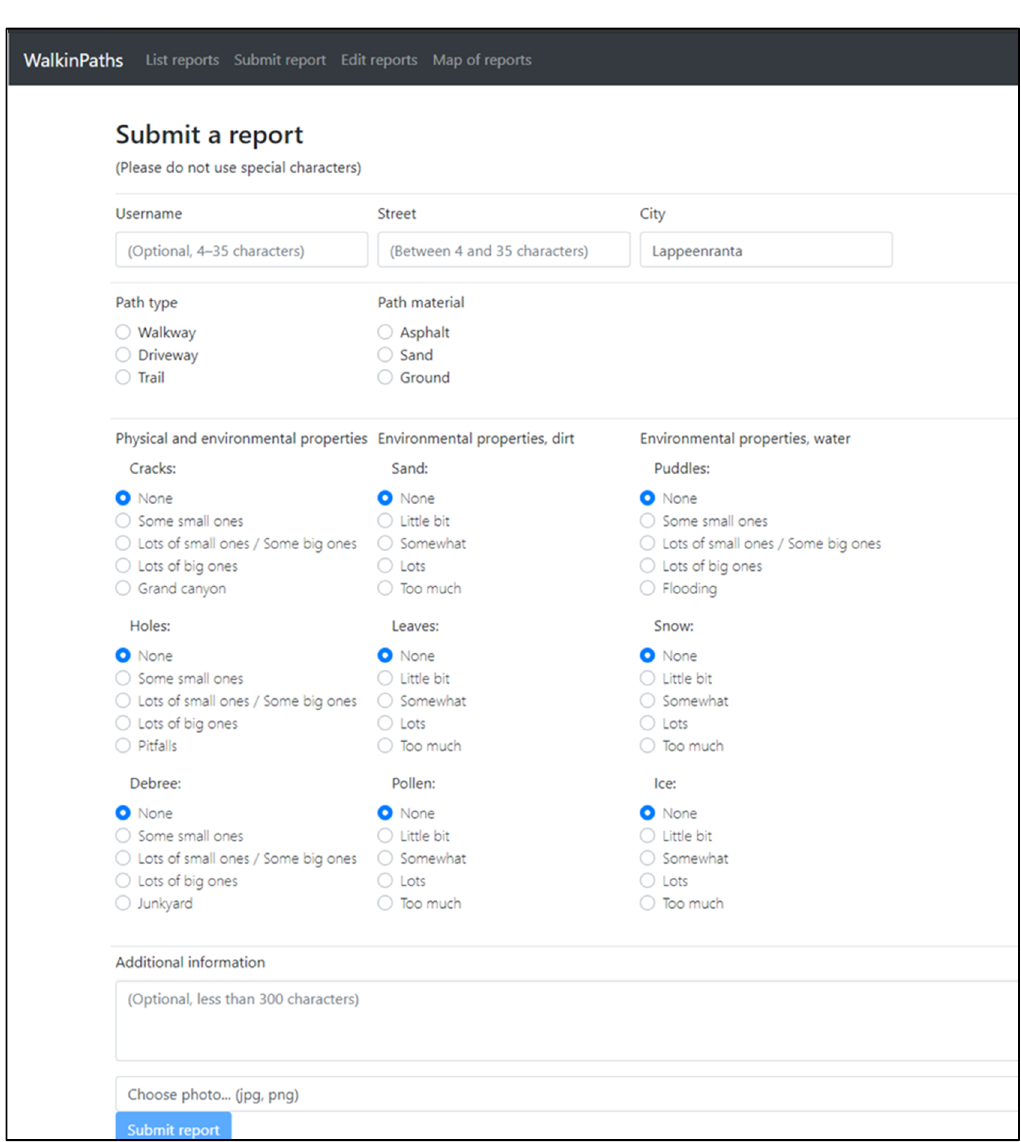
Figure 5. A detailed version of the new observation view.